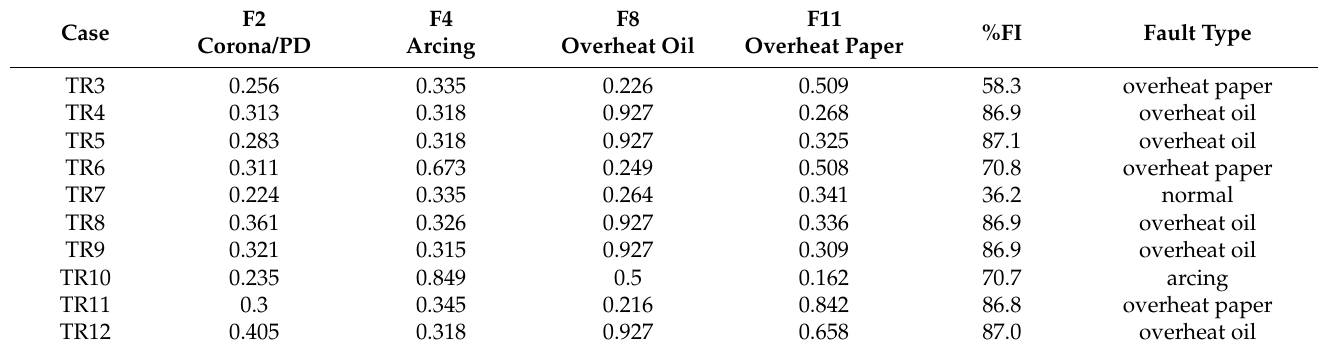
Table 14. Fault identification by the key gas method.